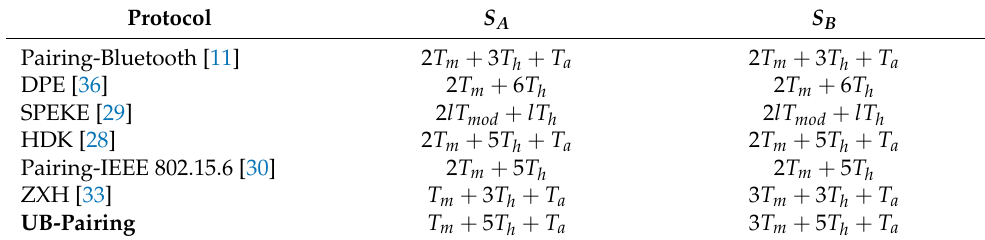
Table 2. Number of cryptography operations required on the two parties in UB-Pairing and related